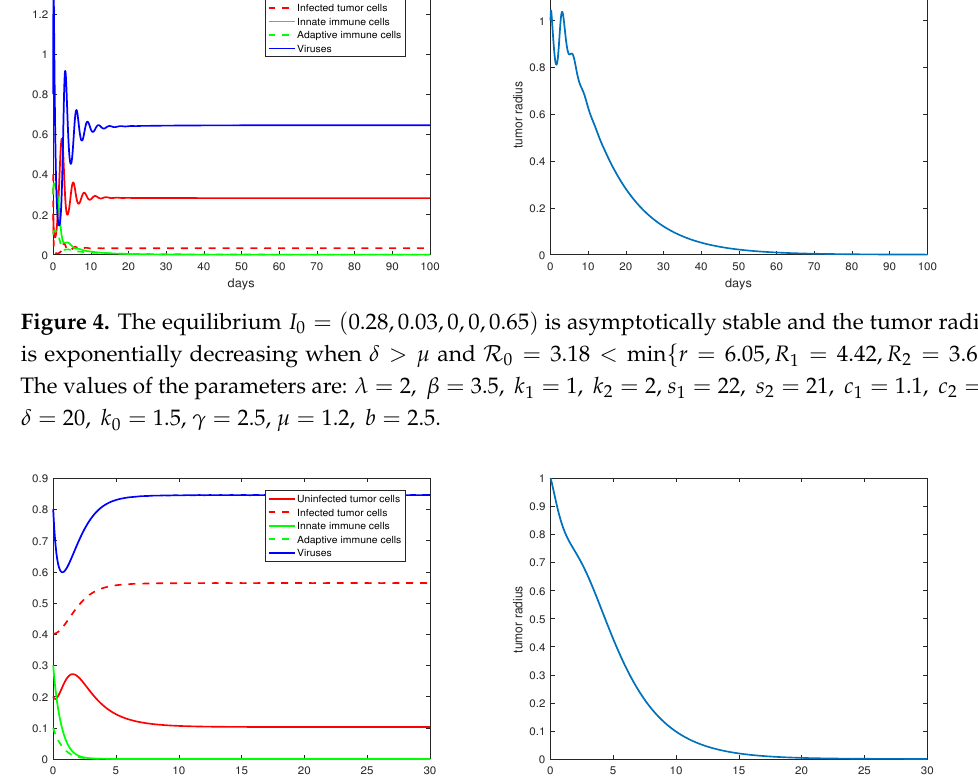
= 1.75, R = 2.06, R = 1.85 } . 2 1 µ − δ